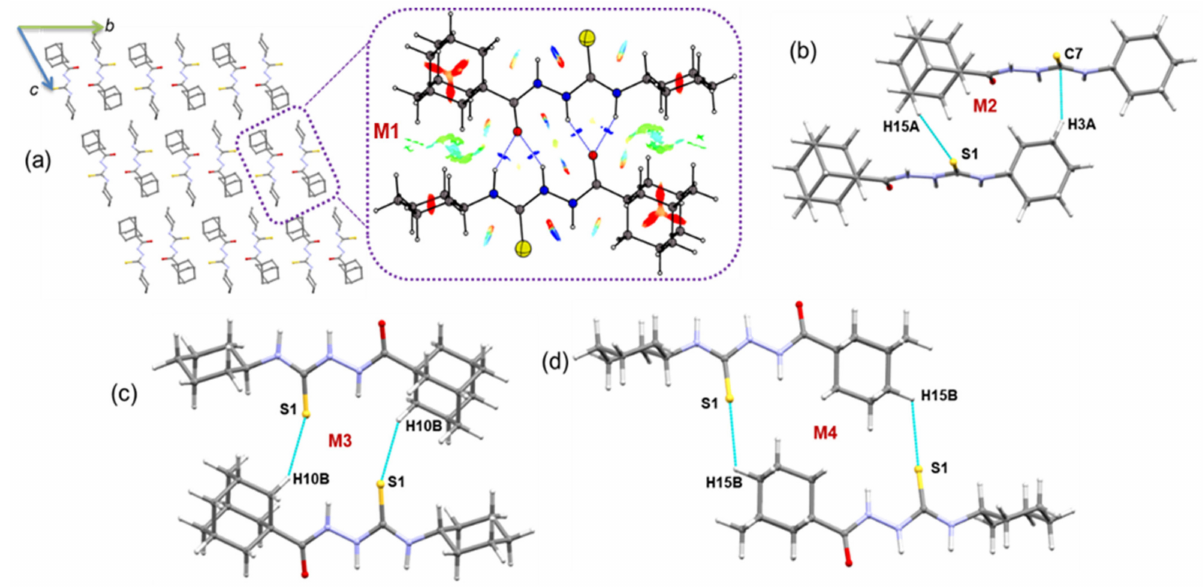
Figure 4. ( a ) Columnar packing of 2 and the NCI plot for the primary motif M1 formed in 2 is shown (dashed box) and ( b – d ) molecular dimers observed in the crystal structure of 2